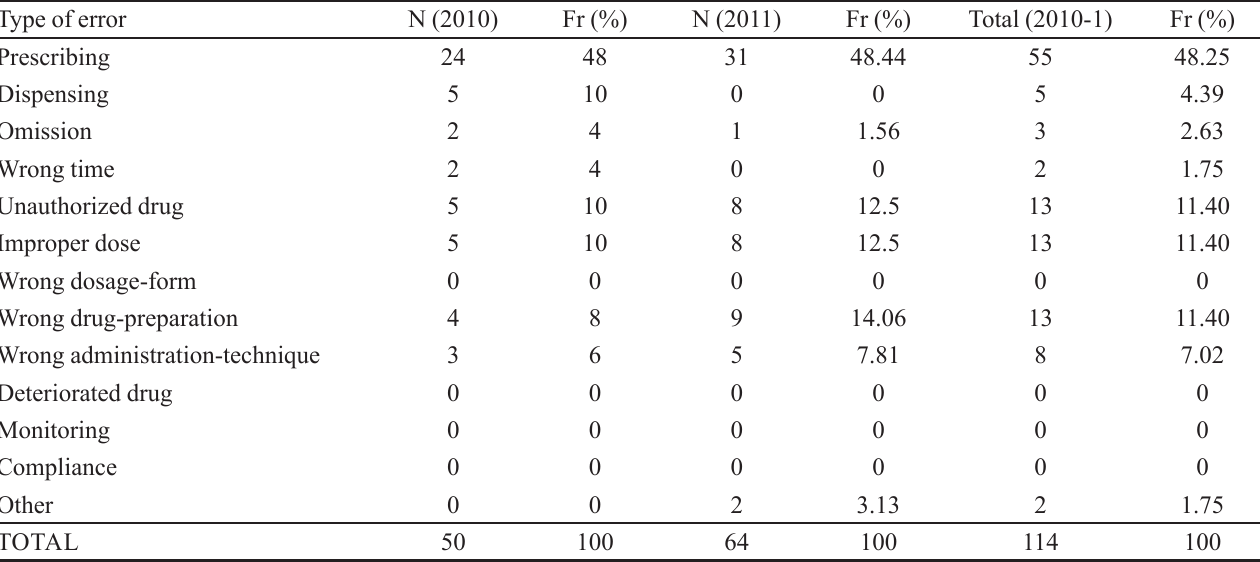
TABLE II - Types of medication errors according to the American Society of Health-System Pharmacists (ASHP), HCPA, 2010